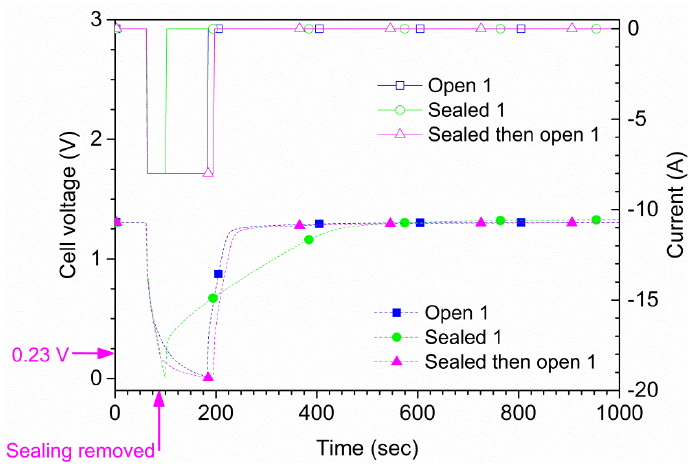
Figure 7. Voltage (filled symbols) and current (open symbols) measurements for cell 1 for three different tests using 8 A; open, sealed; and sealed then open.